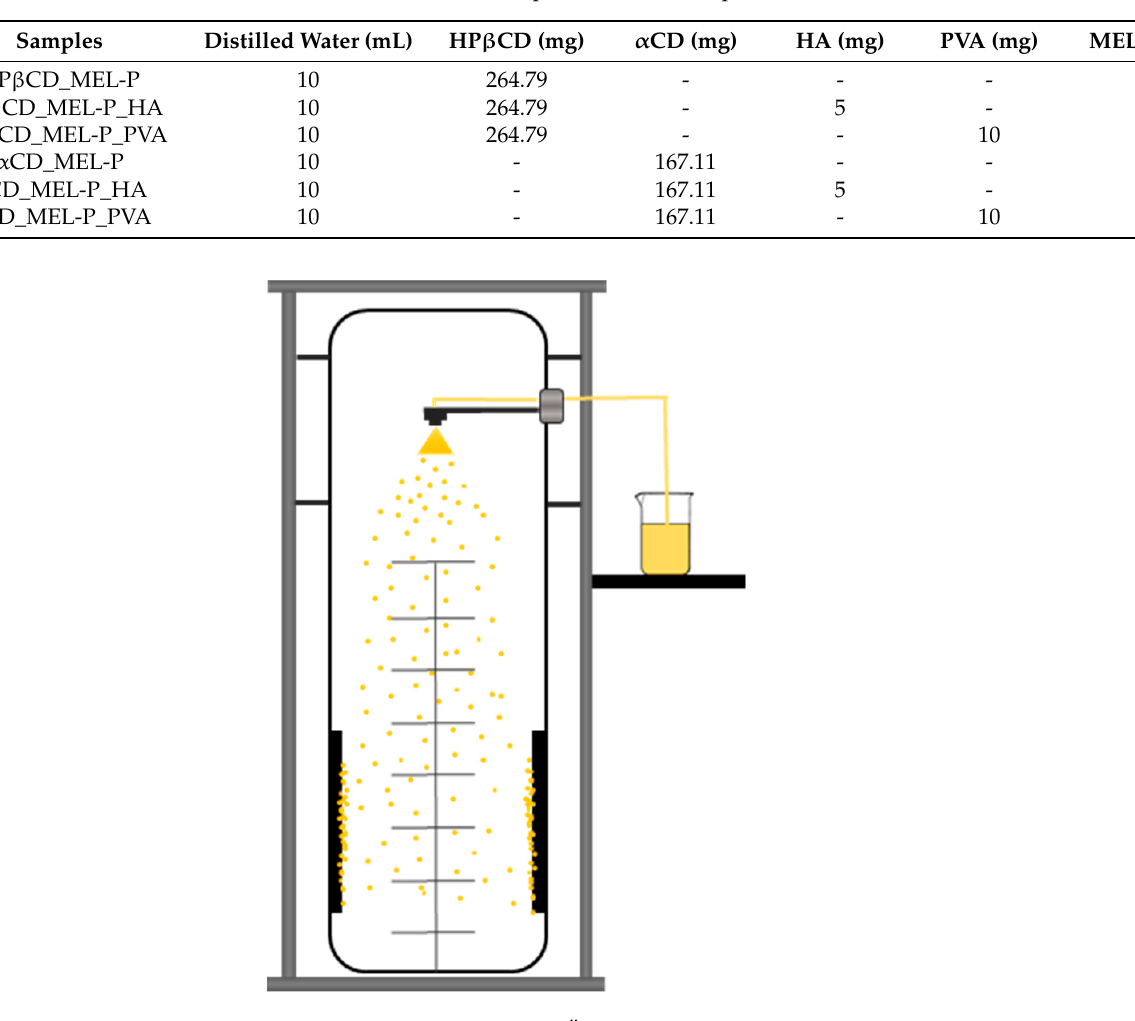
Table 1. Composition of the samples .